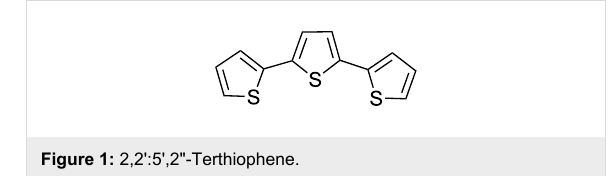
Suzuki, Stille or Negishi Pd-catalyzed cross-coupling reactions represent some of the most efficient methods for the prepar- ation of 2,5-diheteroarylated thiophenes [3-16]. However,